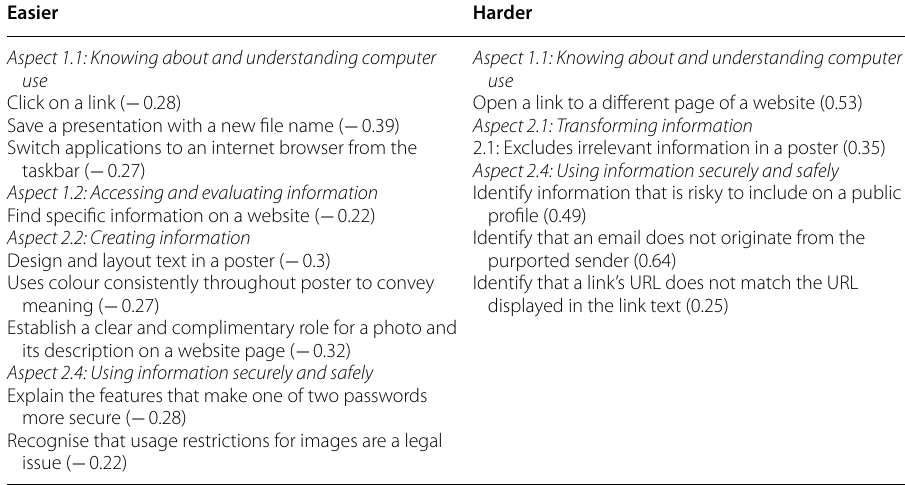
Numbers in parenthesis are the DIF values